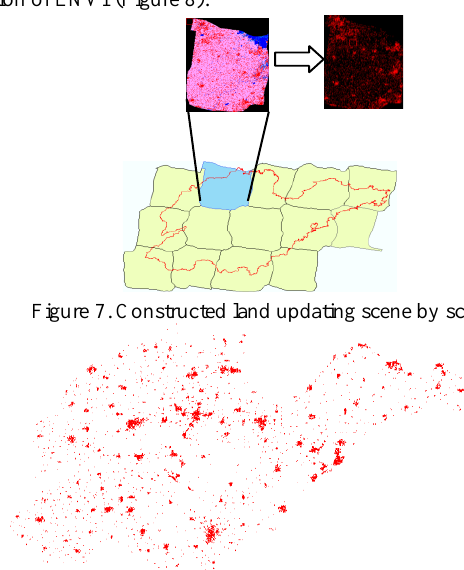
Figure 8. Constructed land 2013 of Shandong province (red